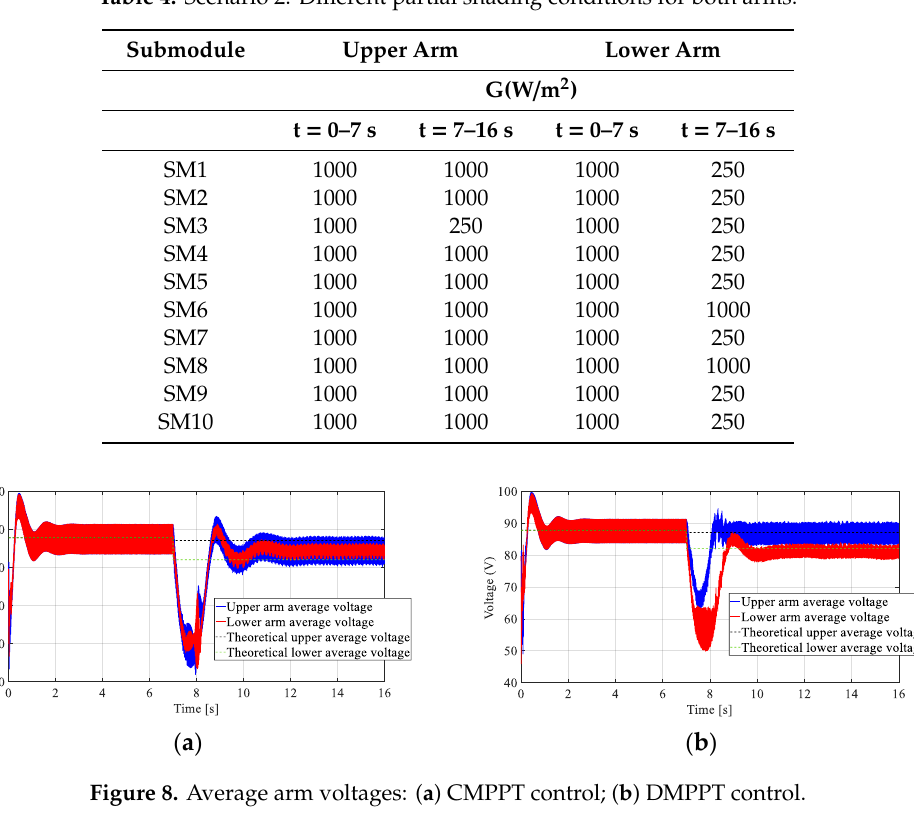
Table 4. Scenario 2. Different partial shading conditions for both arms.